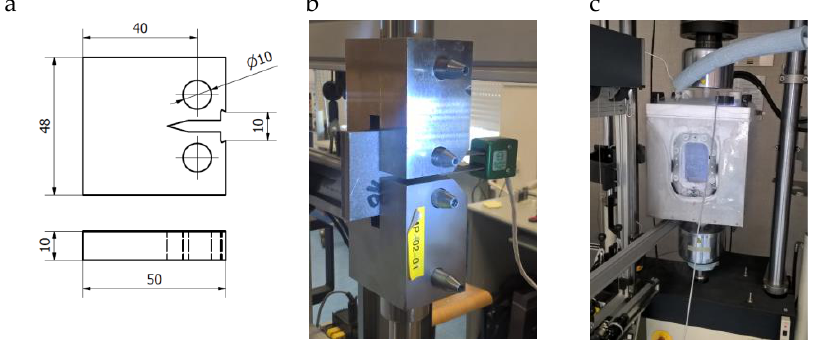
Figure 1. Specimen and stand: ( a ) specimen geometry, ( b ) testing in ambient temperature, and ( c ) test with specimen immersed in liquid nitrogen.